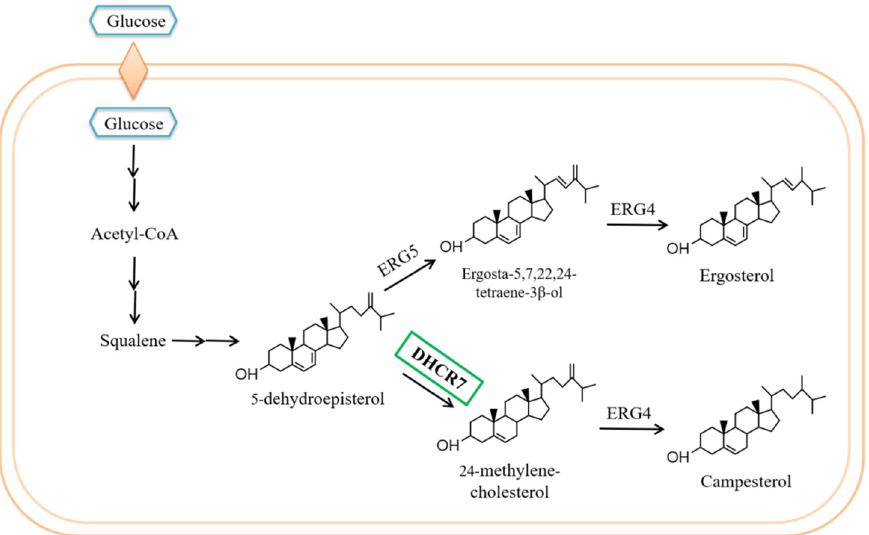
Figure 1. Schematic diagram illustrating the construction of the campesterol and 24 ‐ methylene ‐ cholesterol biosynthesis pathways, based on the native ergosterol biosynthesis pathway in Saccharomyces cerevisiae . The campesterol biosynthesis pathway was constructed by disrupting ERG5 and expressing the heterologous 7 ‐ dehydrocholesterol reductase gene ( DHCR7 ). The 24 ‐ methylene ‐ cholesterol biosynthetic pathway was constructed from the campesterol biosynthesis pathway via the disruption of ERG4. Sterol biosynthesis uses a common acetyl ‐ CoA precursor.